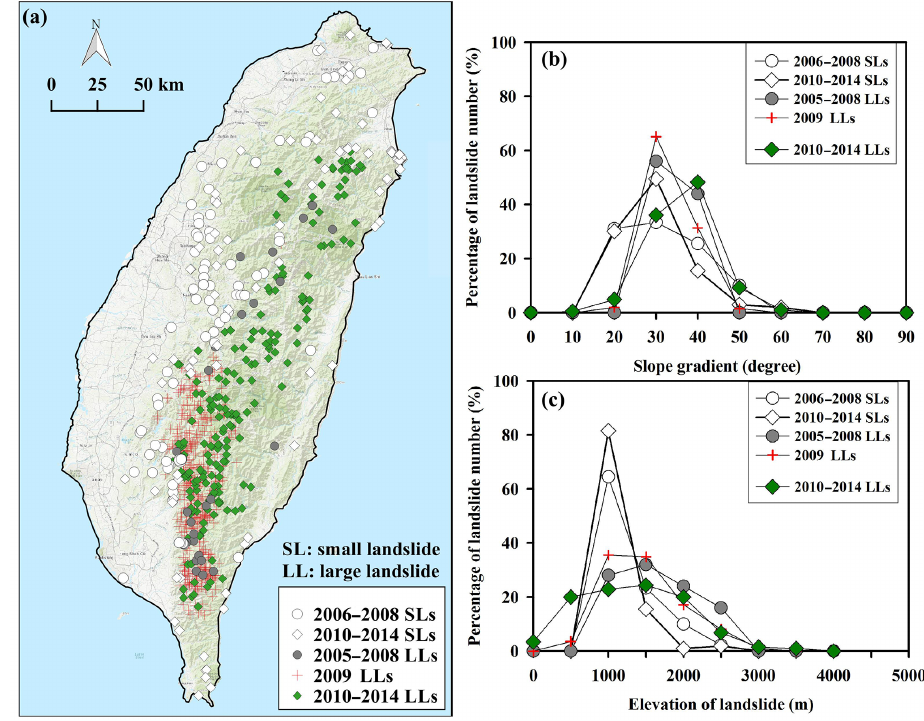
Figure 4. (a) Distribution map of large landslides (LLs) from 2005 to 2014 and small landslides (SLs) from 2006 to 2014. (b) The numerical distribution of slope gradients of large and small landslides, presented in percentages. (c) The numerical distribution of elevations of large and small landslides, presented in